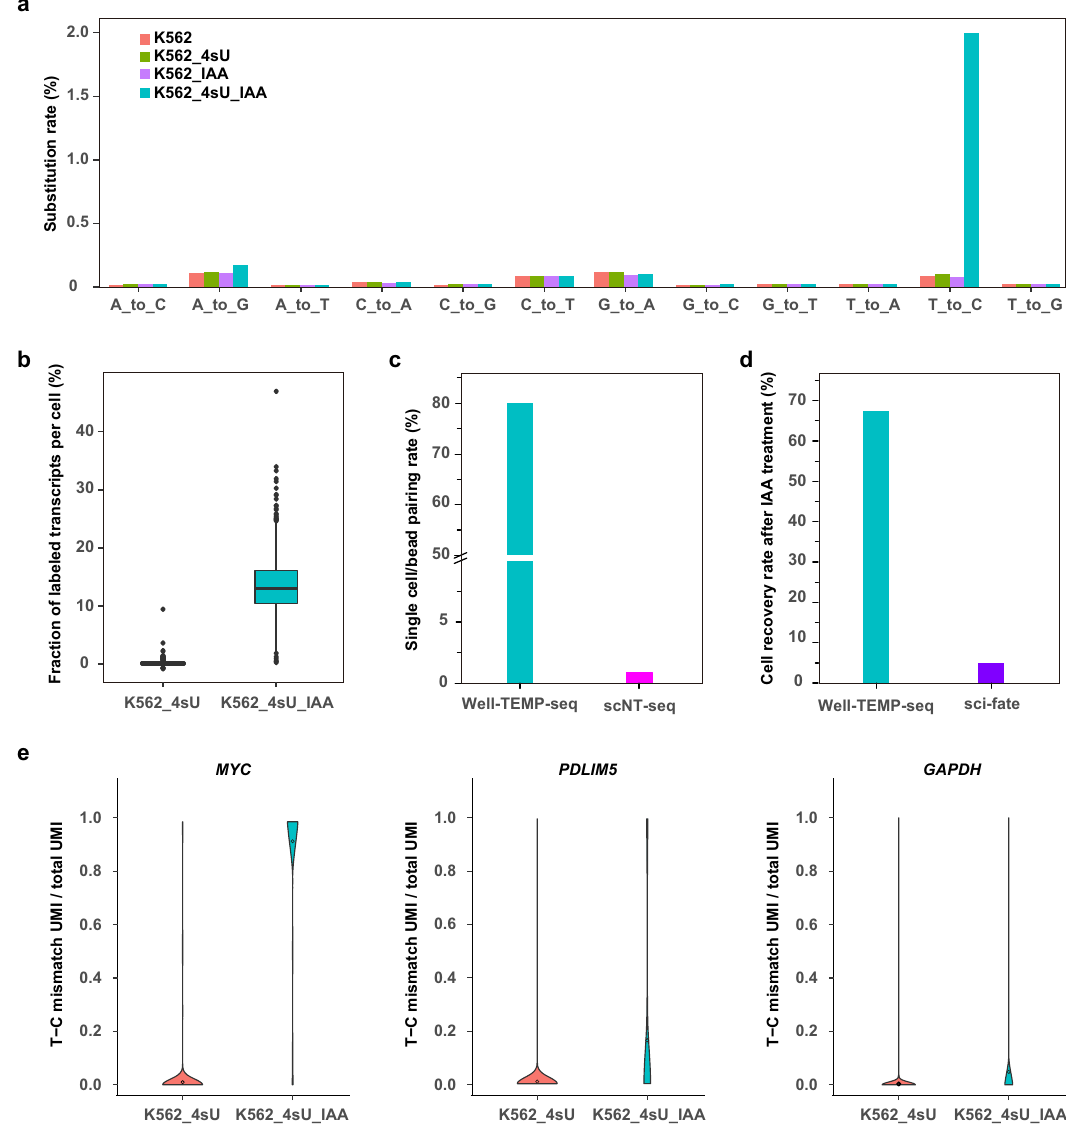
Fig. 2 | Validation of the Well-TEMP-seq performance. a Bar plot of nucleotide substitution rates in K562 cells (K562), 4sU-labeled K562 cells (K562_4sU), IAA- treated K562 cells (K562_IAA), and 4sU-labeled and IAA-treated K562 cells (K562_4sU_IAA). b Box plot of the fraction of labeled transcripts per cell in 4sU- labeled K562 cells and 4sU-labeled and IAA-treated K562 cells. n =2000 cells for each group. Boxplots include centerline, median; box limits, upper and lower quartiles; and whiskers are highest and lowest values no >1.5× interquartile range.